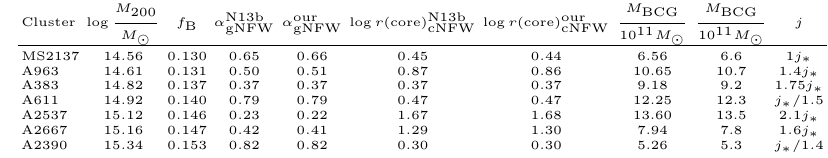
Table 1. Parameters of the clusters. Column (1): the name of the cluster; (2) the M 200 mass given in N13a; (3) the baryon fraction obtained from Giodini et al. (2009) using the previous M 200 masses; (4) the slope (cid:11) obtained by N13b modeling the pro(cid:12)le with a gNFW model; (5) as the previous column but the pro(cid:12)les were obtained using the model of the present paper; (6) the core radius (in kpc) obtained by N13b modeling pro(cid:12)le with a cNFW model; (7) as the previous column but the pro(cid:12)le is obtained using the model of the present paper; (8) the BCG mass and errors obtained in N13a; (9) as the previous column but using the model of the present paper; (10) the value of j . M 200 M BCG M BCG Cluster log f B (cid:11) N13b gNFW (cid:11) our gNFW log r (core)N13b cNFW log r (core)our cNFW 1011 M ⊙ 1011 M M ⊙